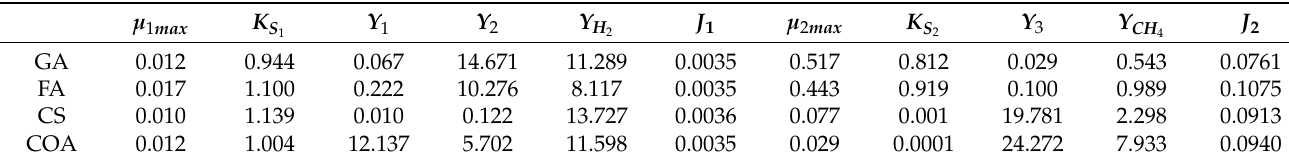
Table 2. Model parameter